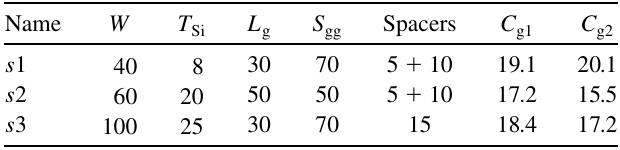
between the central island and, respectively, gates 1 and 2.